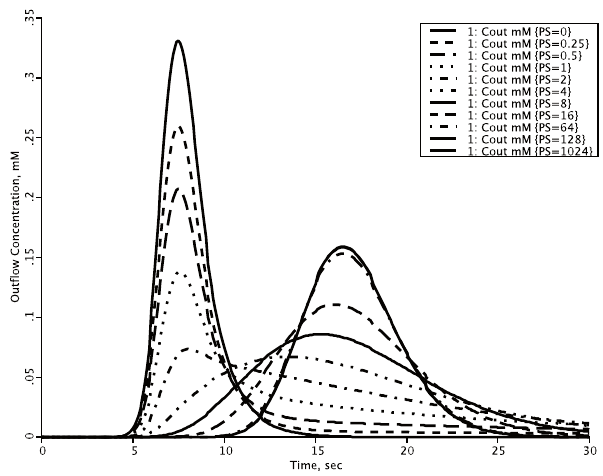
Figure 2. Using LOOPS to explore parameter influences. [Model is in Figure 1, with the computer code in Box 2]. With the permeability surface area product (PS) = 0 (tallest solid curve) in the axially distributed capillary-tissue model in Figure 1, the outflow concentration- Figure 3. Nested plots. Behavior of the two-region model when time curve, C , represents the response function through the out varying capillary permeability, PS , and tissue consumption, G . vascular space alone. The mean transit time for this curve is V /F . isf cap cap Each panel is a contour plot: the abscissa is position x between With finite permeability, PS, there is extraction of solute during the capillary entrance at x =0 to the exit at x =0.1 cm; the ordinate is transcapillary passage, shown by the successive diminutions of the time, t . At each time t a horizontal line from 0 to 20 is colored (using heights of the initial peaks as PS increases. At low PSs the form of color profile “rainbow” in this case) in accord with the concentration the outflow begins for a second or so as a reduced version of the (highest is blue, to which each contour plot is scaled, down to red curve with PS = 0. At low PSs the flux into the tissue is purely “barrier for zero concentration) at each point in x . Convection moves the limited”, i.e. the permeation of the barrier has the dominant influence entering solute along the tube from left to right to larger x on this on the shape of the outflow curve. When PS is 4 or greater ml/ graph. With successive times the colored horizontal lines construct (g*min), the sixth curve, the initial peak is no longer discernable; at a shaped profile above the x-t plane; contour lines with units in mM yet higher PSs a second peak arises, and at PSs above 128 ml/(g*min) are superimposed. The columns from left to right show contours increasing the PS further has no effect on the shape of the outflow with PS increasing by factors of 5 (see labels at top of column) curve and at high PSs the exchange flux is purely “flow-limited”, from PS = 0.3 to 37.5 ml/(g*min). The rows go from consumption where changing the flow shifts C , but changing PS does not. When out G = 0.2 ml/(g*min) in the bottom row by factors of 5 to the top PS > 0, then the mean transit time for all the curves is (V + V )/ isf cap isf row with G = 25 ml/(g*min); see labels on right ordinate. With low F . Thus there is a gradual shift from being purely barrier-limited, isf cap PS , leftmost column, as with the low PS outflow curves at Ccap(t, through a mixed barrier- and flow-limited regime to a purely flow- x=L) or Cout(t) of Figure 2, very little of the solute escapes into the limited regime at high PS where the shape of the curve is influenced tissue, so the injected bolus remains relatively compact even while only by changes in flow, but the mean transit time is unchanged over undergoing some diffusional spread ( D = D = 10 -4 cm 2 /sec), and the whole range, PS > 0 to PS = 1024 ml/(g*min), being obedient to cap isf the influence of the consumption is negligible since so little enters the laws of conservation of mass. the ISF. With increasing PS more solute enters the ISF where it is consumed. With high PS and high G , the right uppermost panel, isf the solute is all consumed before it can reach the capillary exit at the right edge of the panel. [This plot is set up under “Project”, “Add”, “New Nested Plot” using LOOPS, inner and outer, to set the values for the parameters, and on the NestedPlot, then clicking on “XY plot” to choose “contour”. Instructions are under Running JSim – Data Analysis – Nested plots: